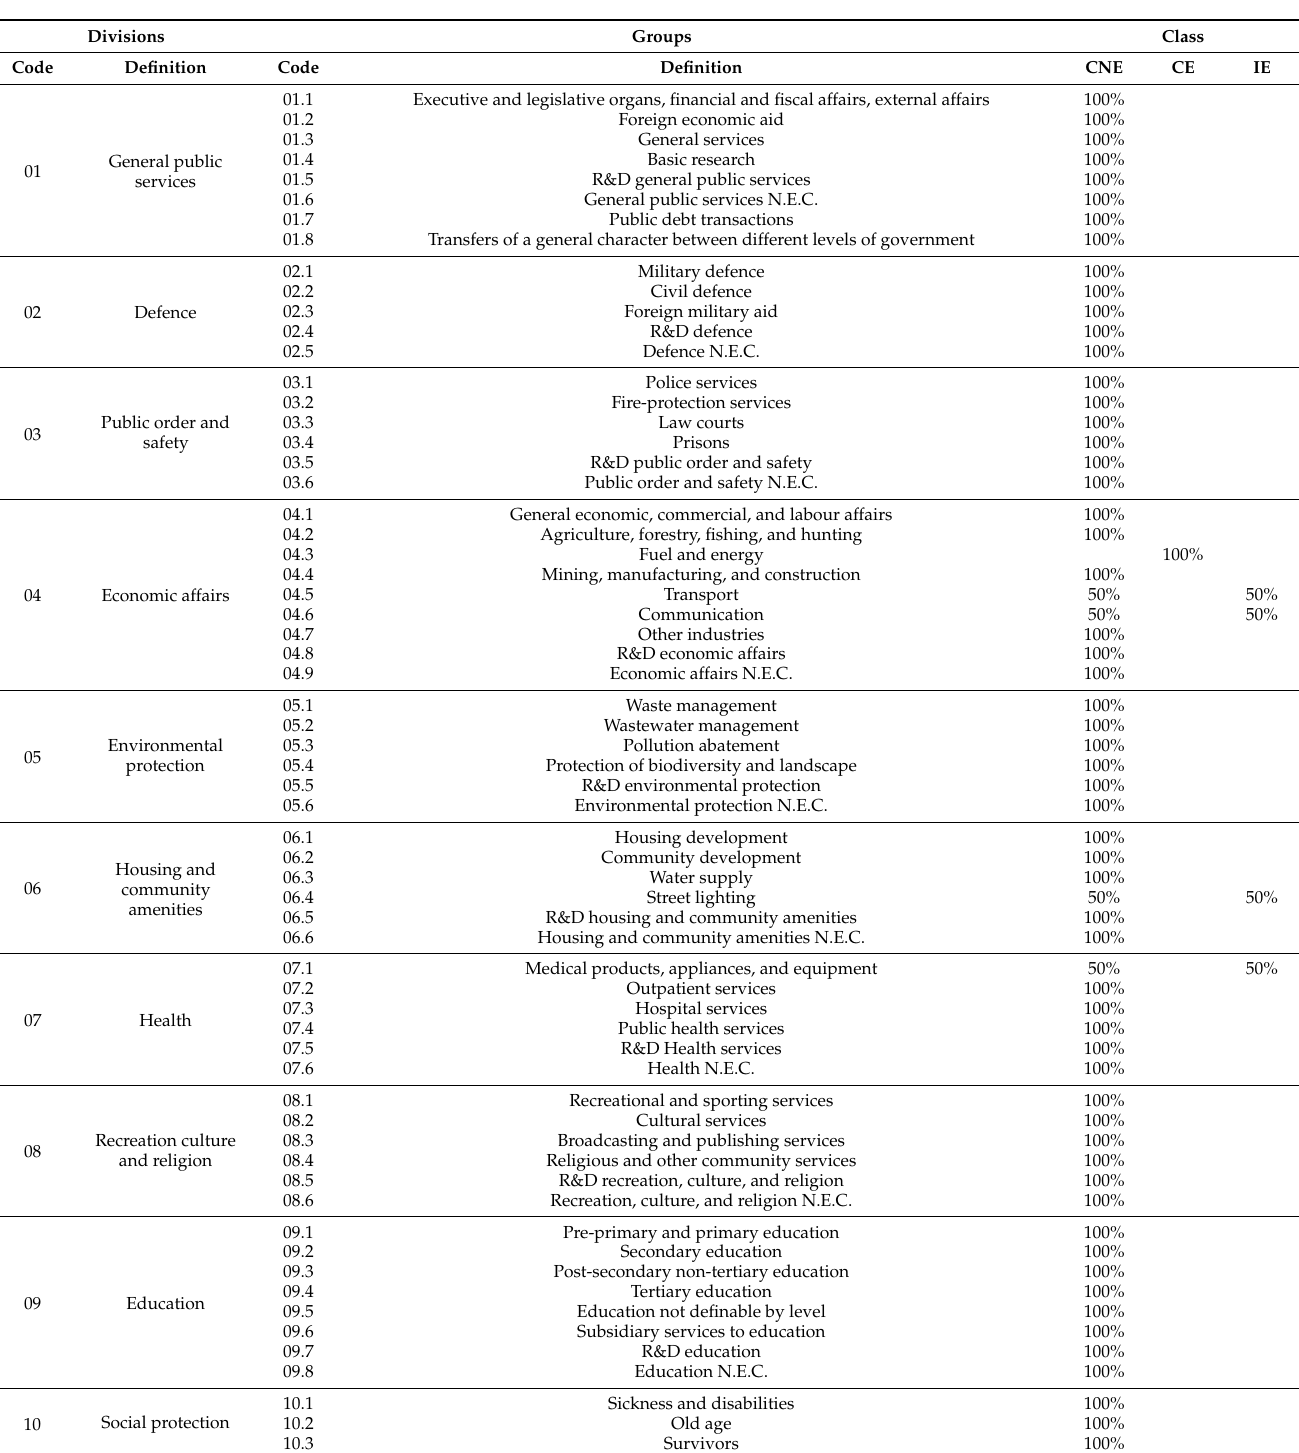
Table A2. Reclassification of the final consumption of government (COFOG). (Adapted from